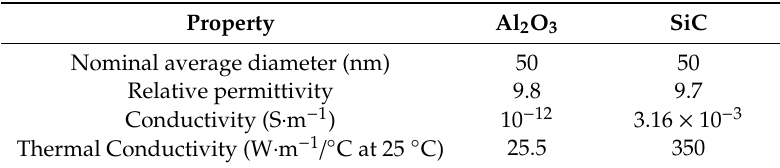
Table 1. Dielectric and thermal properties of the NPs.